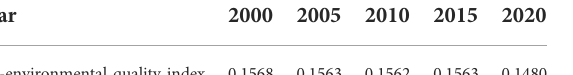
TABLE 3 Eco-environmental quality index for the study